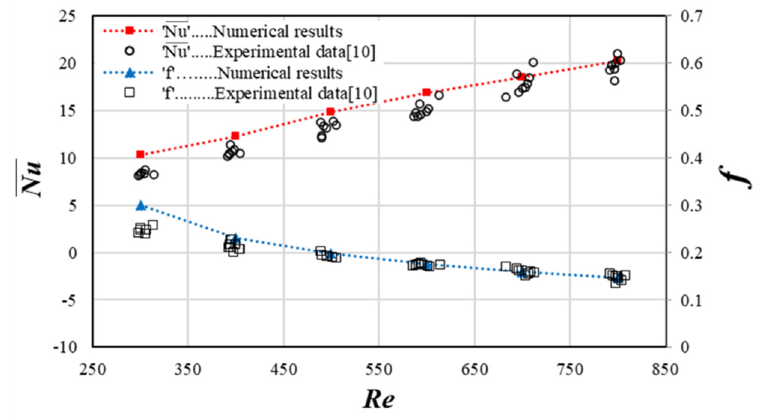
Figure 8. Validation of numerical results compared with experimental data [10]. Table 4. Performance comparison between reference and smooth wavy microchannels.